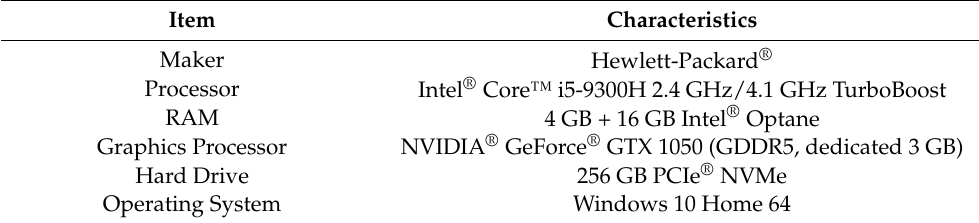
Table 4. Technological equipment used to run the algorithms.